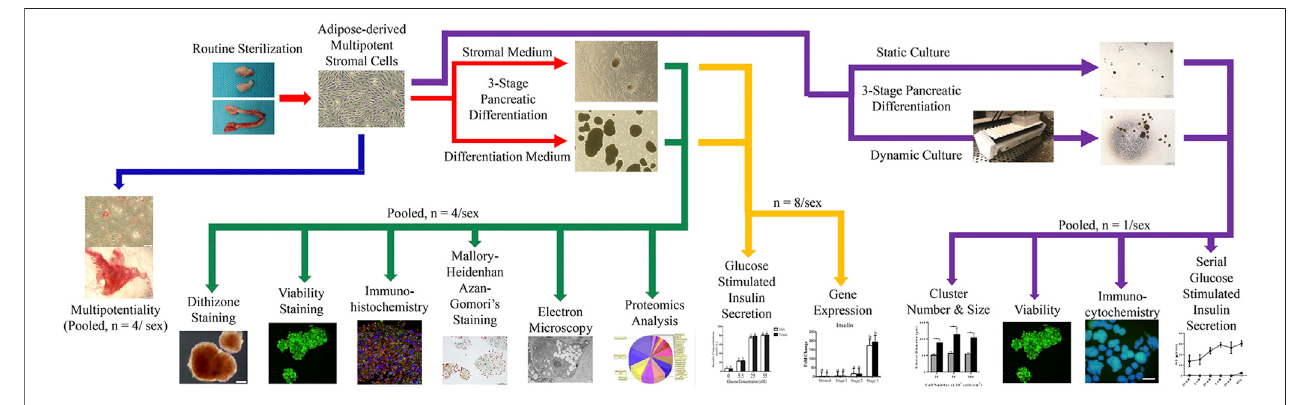
FIGURE 1 | Study design